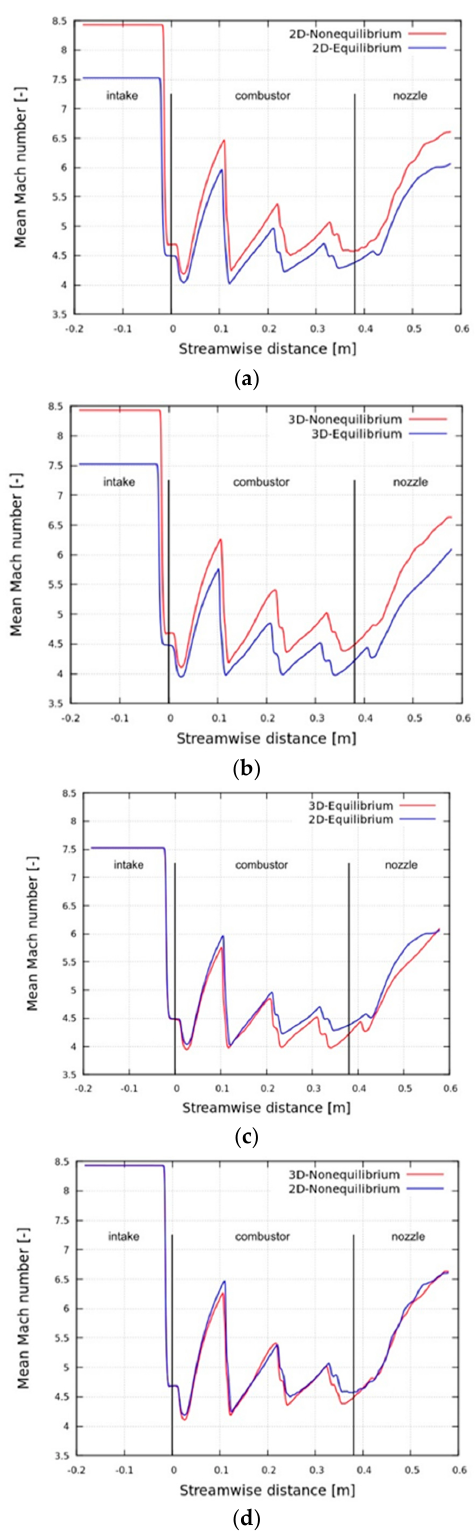
Figure 11. Distributions of Mach number along the centerline ( y = 0, z = 0): ( a ) 2D cases; ( b ) 3D cases; ( c ) equilibrium cases; ( d ) nonequilibrium cases.